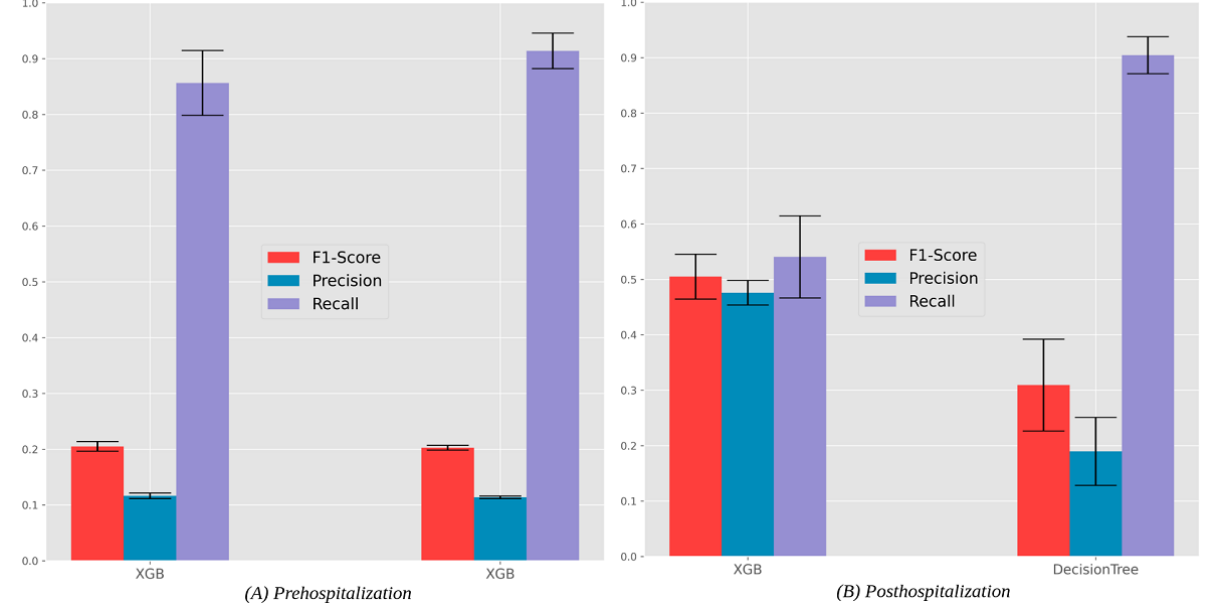
Figure 6. Predictability of intensive care unit admission. Results for the best F1 predictor (left) and recall-oriented predictor (right). XGB: XGBoost.